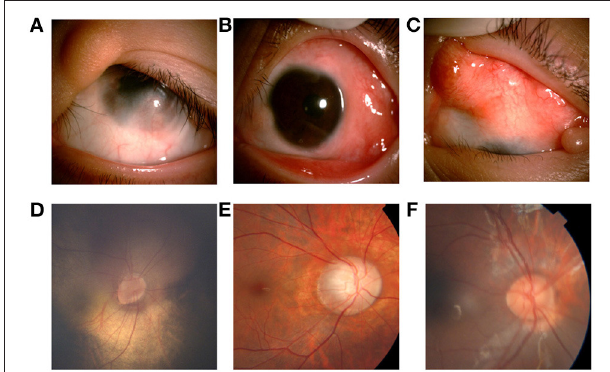
FIGURE 2 | Ocular manifestations of patients with LNSS an OES-ECCL. Single flat epibulbar choristoma involving the cornea with unclear boundaries and upper eyelid coloboma with skin tag (LNSS, patient 9) (A) . Mutiple epibulbar choristomas involving the cornea, and esotropia (LNSS, patient 1) (B) . Large, raised epibulbar choristoma, and upper eyelid coloboma (ECCL, patient 25) (C) . The oval optic disc, inferior temporal optic disc coloboma, and the vessels crawl out the edge of the disc, which is similar to the pattern of morning glory disc. The patient with corneal choristoma was examined under anesthesia (LNSS, patient 3) (D) . The boundary of the optic disk is not clear with a lighter color, and the exposed scleral ring can be seen around the disk (ECCL, patient 25) (E) . Congenital coloboma of the optic disk (OES, patient 14) (F) .